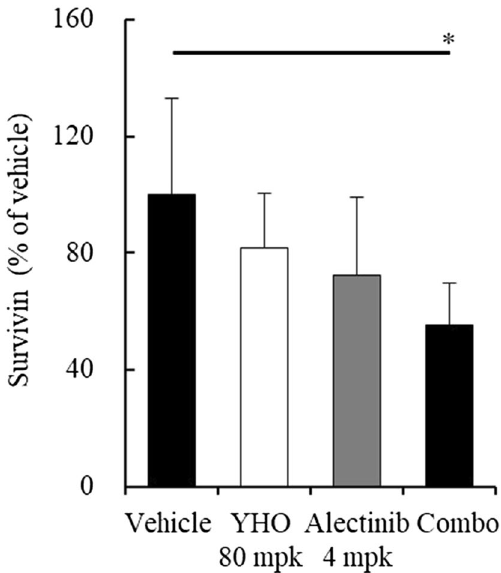
Figure 7. Downregulation of the downstream target survivin in tumor tissues. Lysates prepared from H2228 xenografts in Fig. 6E were subjected to further analyses. Survivin levels were determined by ELISA. Significance was determined by Tukey’s test. *p < 0.05 versus the vehicle group. mpk, milligrams per kilogram of body weight; YHO,